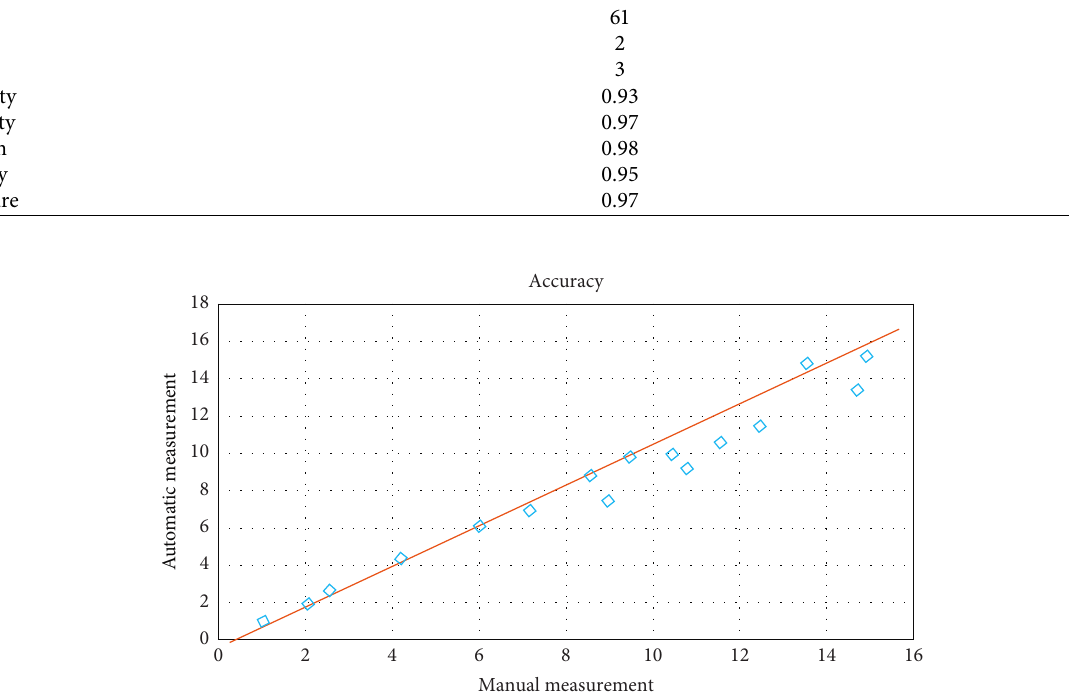
Figure 11: Comparison of manual measurement versus automatic method.